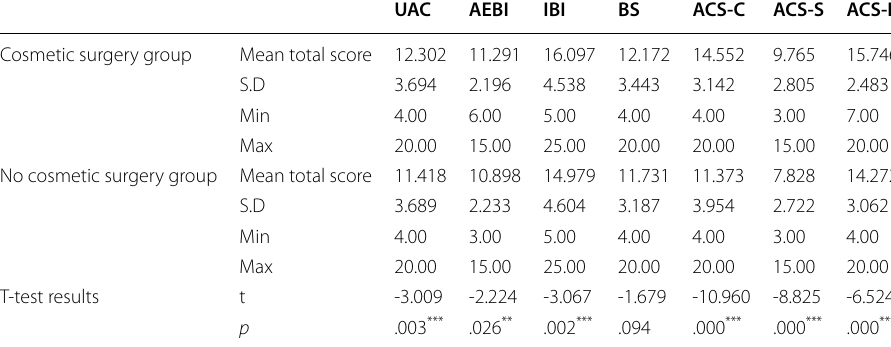
*** p < 0.01, ** p < 0.05 UAC, upward appearance comparison; AEBI, awareness of an emphasis on beauty ideals; IBI, internalization of beauty ideals; BS, body surveillance; ACS-C, acceptance of cosmetic surgery: consider dimension; ACS-S, acceptance of cosmetic surgery: social dimension; ACS-I, acceptance of cosmetic surgery: intrapersonal